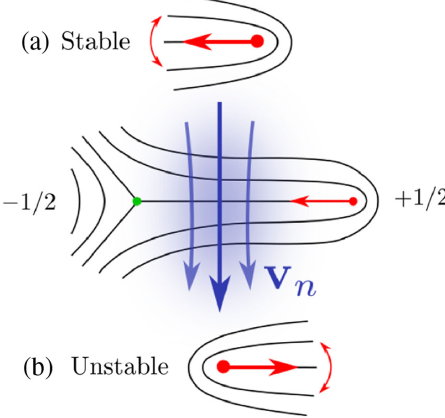
FIG. 4. The orientational stability of a test þ 1 = 2 disclination placed in the vicinity of a neutral (cid:1) 1 = 2 defect pair, shown here for extensile activity ( v < 0 ). The (cid:1) 1 = 2 defect pair creates a background phase gradient v n (blue arrows) as a result of the nematic distortion. The test disclination experiences an active torque due to the presence of a background phase gradient v n that picks out a stable orientation as shown in (a). The torque- stabilized orientation is one in which the test defect is aligned parallel to the defect pair. All other orientations of the test defect, including being antiparallel to the defect pair as in (b), are unstable due to the active